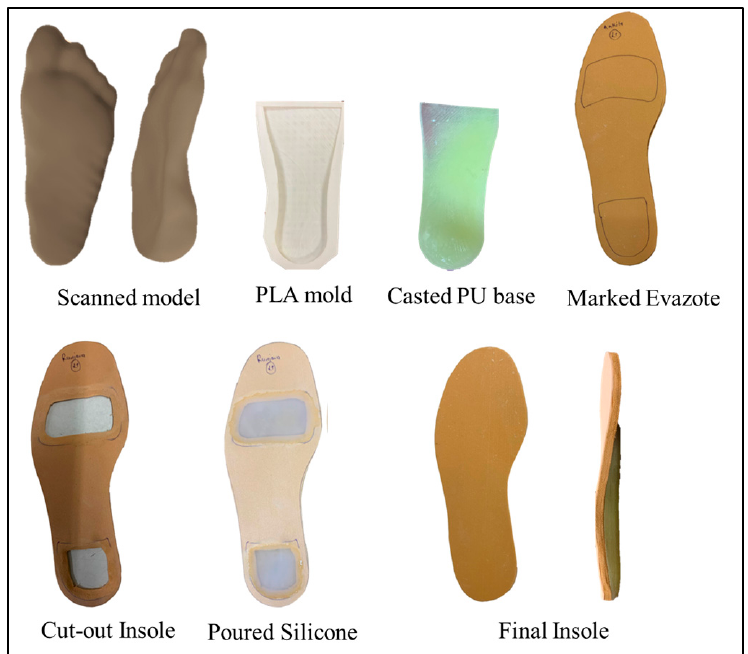
Figure 3. Fabrication procedure of the insole.